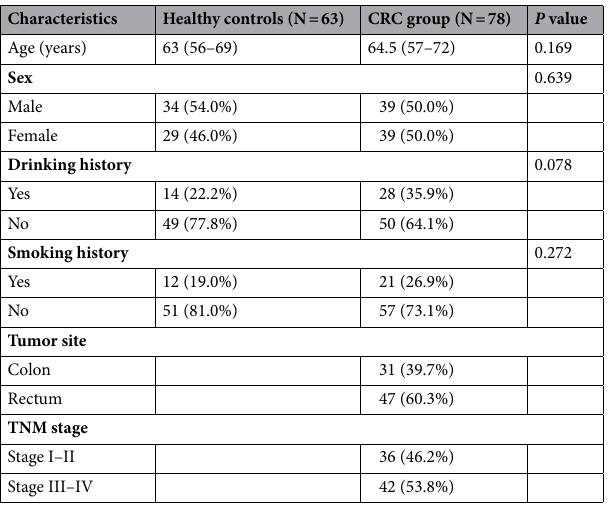
Table 1. Basic characteristics of healthy controls and CRC patients to study the number and phenotype of T and B lymphocytes. CRC, Colorectal cancer; TNM,